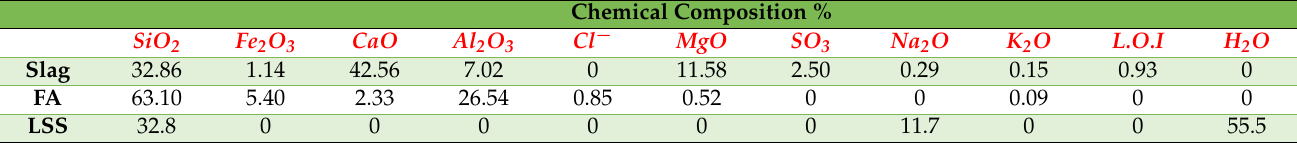
Table 1. Chemical composition of starting materials by XRF, mass %.